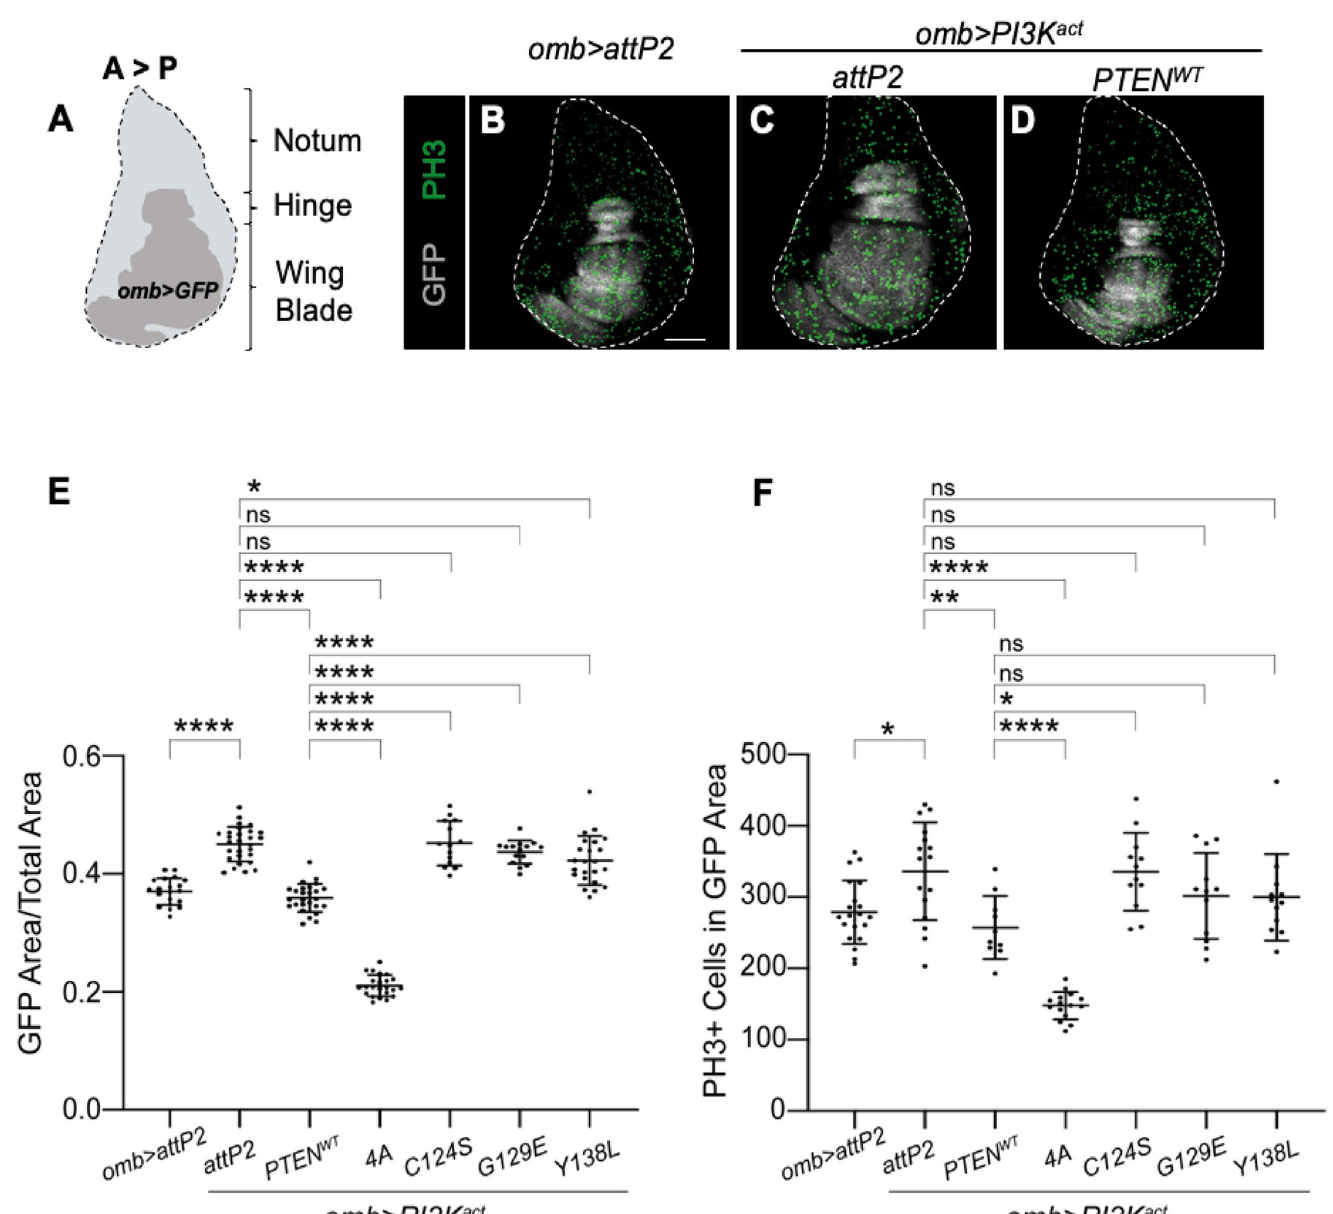
Fig 3. Human PTEN suppress PI3K-induced proliferation in Drosophila wing imaginal discs. Wing pouch specific driver omb-GAL4 expressed UAS-PI3K act and UAS-PTEN variants in the developing wing disc. Illustration of a Drosophila imaginal wing disc showing regions that develop into specific adult tissues after metamorphosis. The anterior to posterior axis (A > P) and the omb-GAL4 expression domain ( omb > GFP ) are shown (A) . Representative images of wing discs of 3 rd instar female larva, with the wing pouch area marked by GFP (in grey) and PH3+ cells (in green) stained with anti-PH3 antibody for genotypes as shown (B–D) . Graph showing ratio of GFP area over total area of the disc ( E ) and PH3 positive cells ( F ) in wing imaginal discs of each genotype. Expressing PTEN-WT reduced PI3K act induced proliferation. Each datum point in scatter plots represents a single wing imaginal disc. Data are expressed as mean ± SD and analyzed using one-way ANOVA with Tukey HSD post-hoc; p > 0.05, � p < 0.05, �� p < 0.01, ���� p < 0.000.1. ns = not significant. Scale bar is 100 μ m.